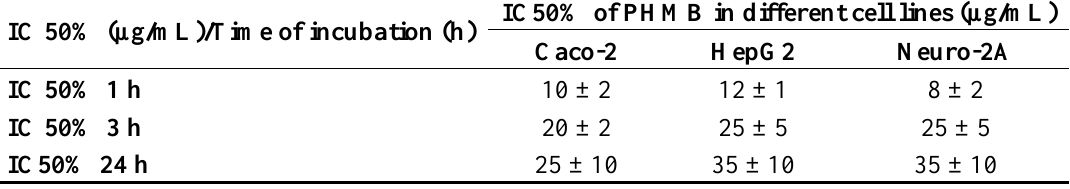
Table 2. Evaluation of cellular viability using the neutral red test, following 1, 3 and 24 h of incubation with PHMB in the three selected cell